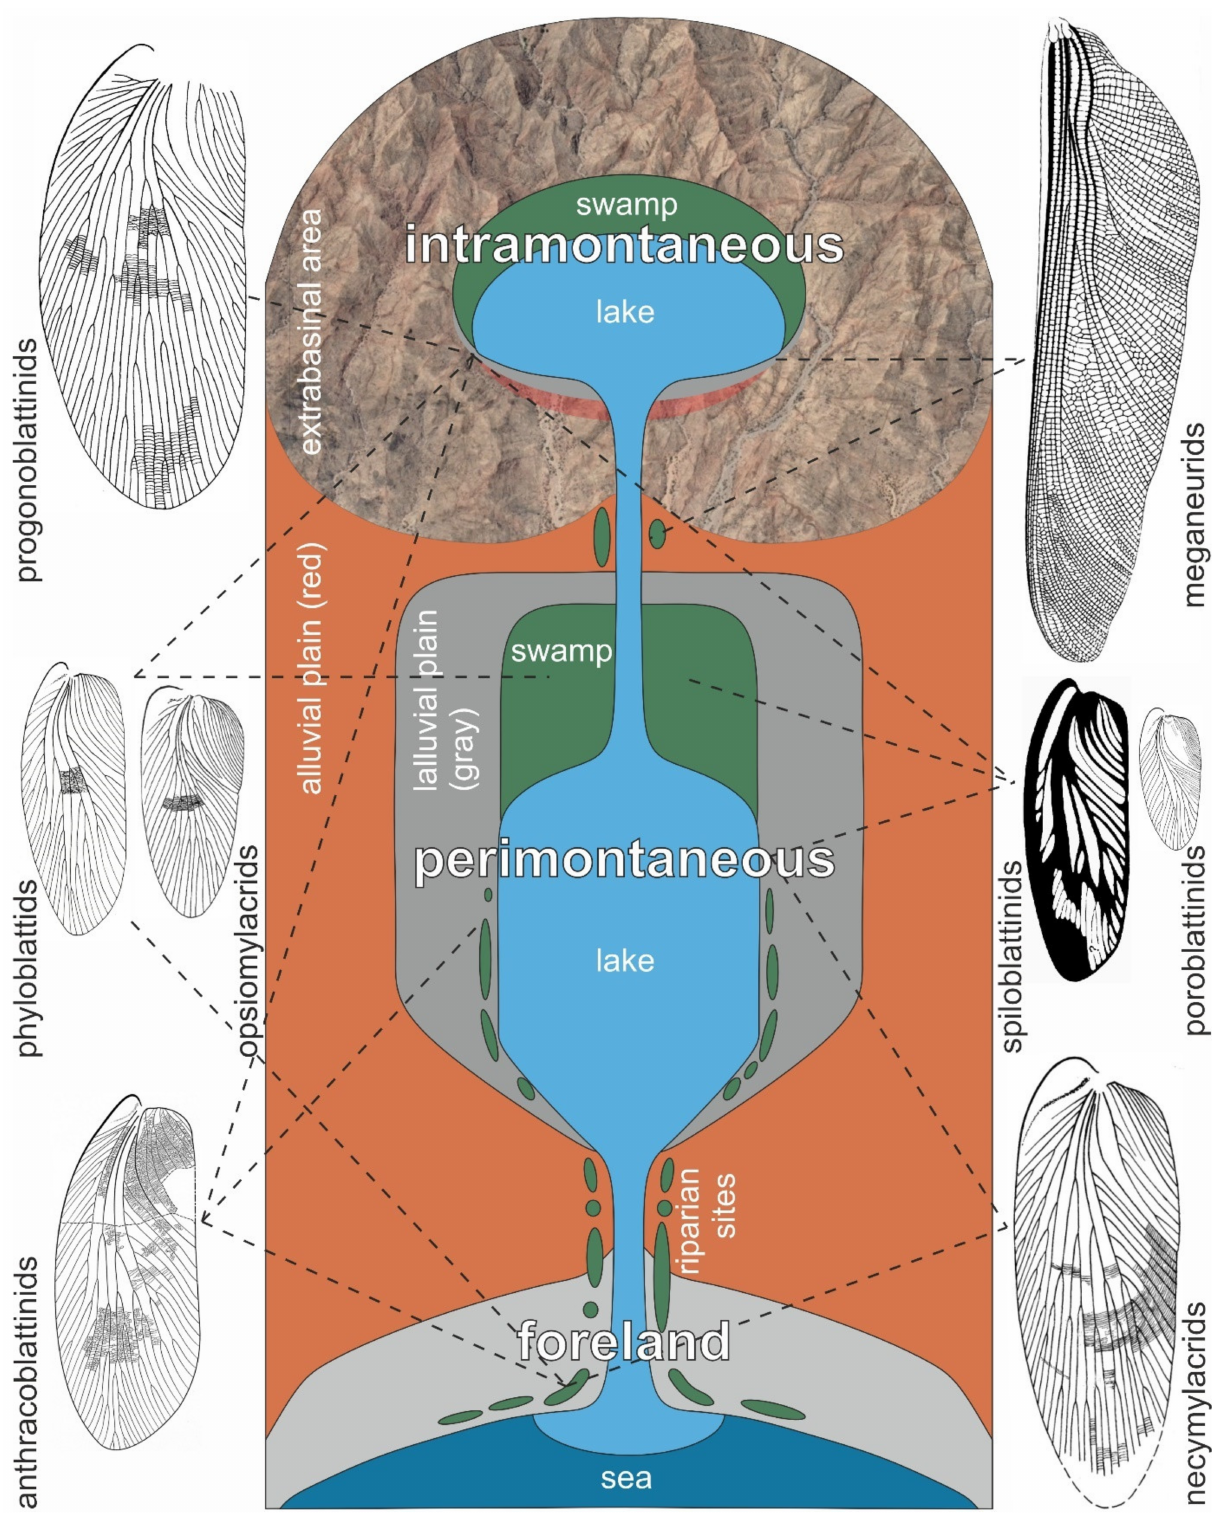
Figure 21. Preferred habitats of the most common blattoid and meganeurid insects during the Late Pennsylvanian. The insect localities of this time frame (see Figure 1) are situated in the basinal gray facies of the Euramerican biotic province. Localities in the surrounding wet red bed facies are virtually unknown so far due to sampling